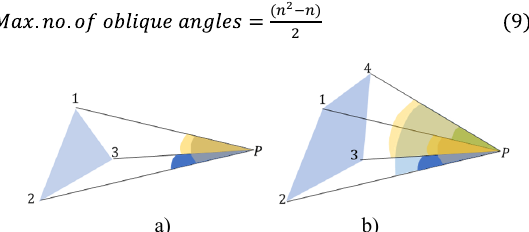
Figure 4. The composed oblique angles related to three and four observed control points. a) three observed oblique angles. b) six observed oblique